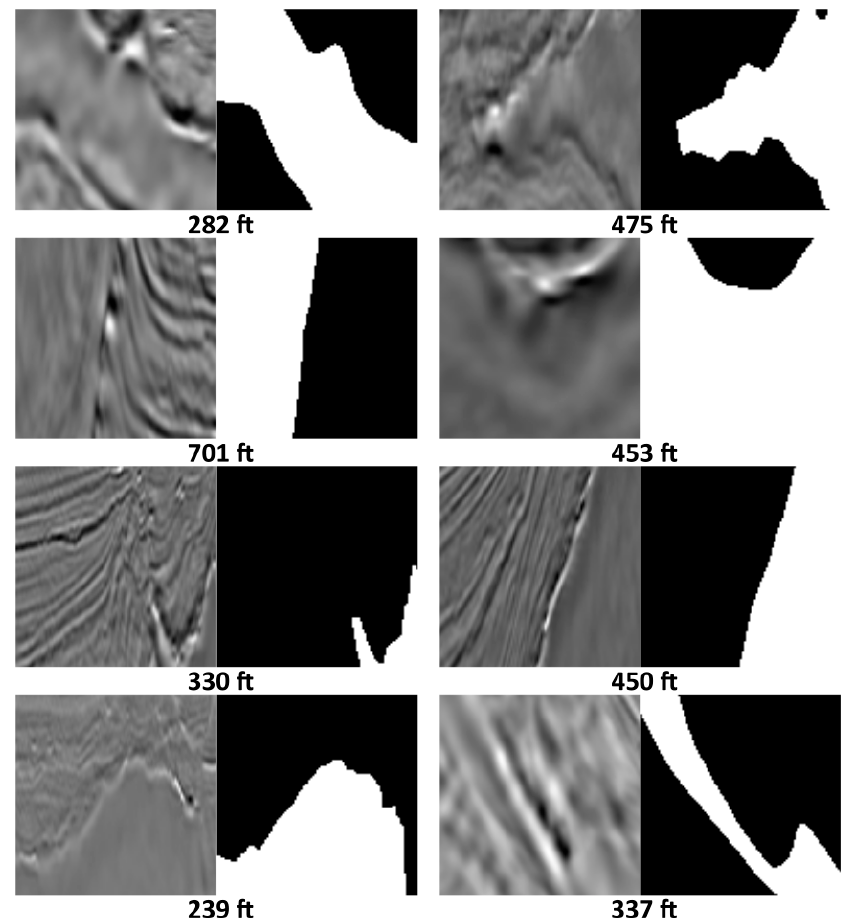
Figure 3. An example of several patches of the seismic image with corresponding salt deposit mask and depth information.